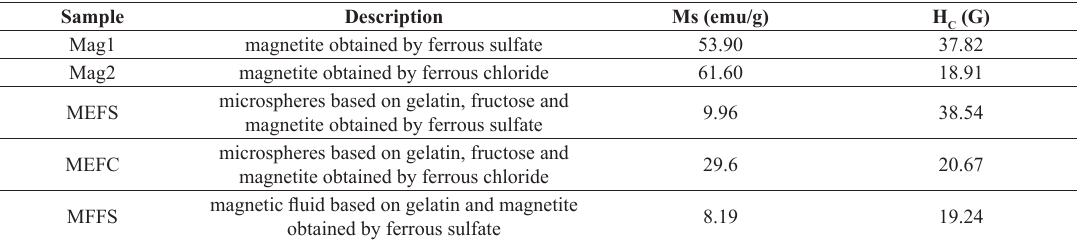
Table 3. Magnetic properties of the magnetite and magnetic gelatin microspheres. Sample